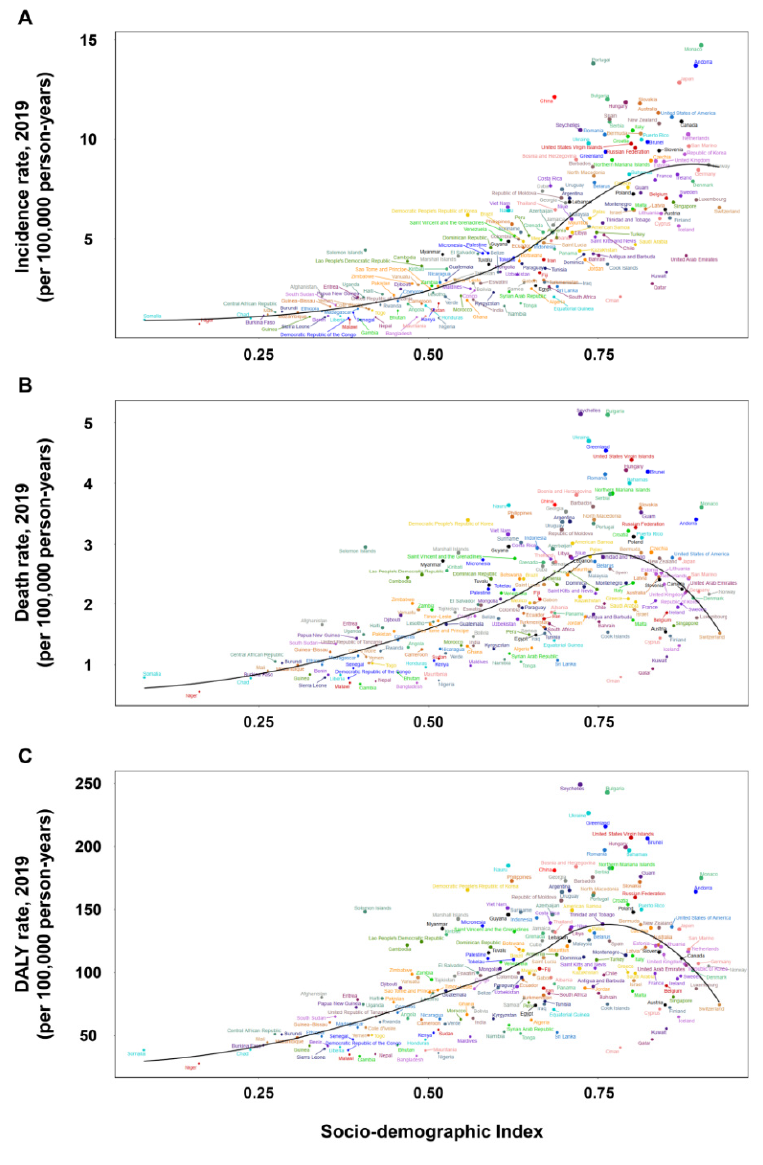
Figure 4. The incidence rate ( A ), death rate ( B ), and DALY rate ( C ) of early-onset CRC at the national level by SDI, 1990–2019. CRC: colorectal cancer; GBD: Global Burden of Disease; SDI: sociodemographic index.